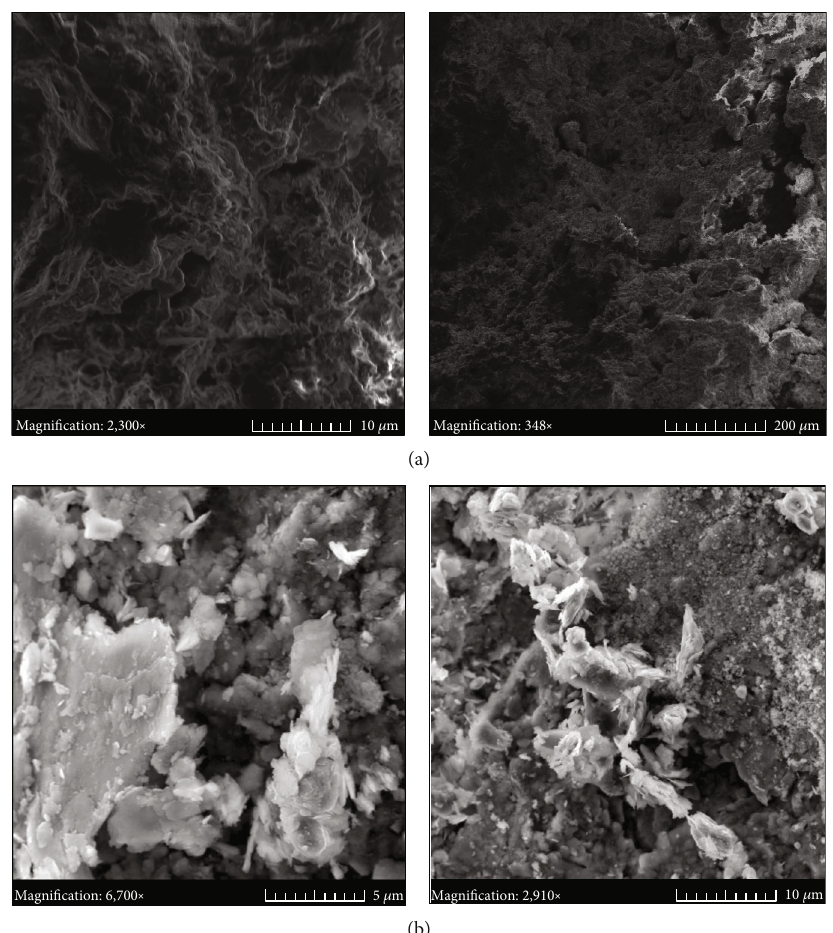
Figure 8: SEM images of (a) pure clay and (b) 3% polymer-treated clay. Both are conserved in room condition for 9